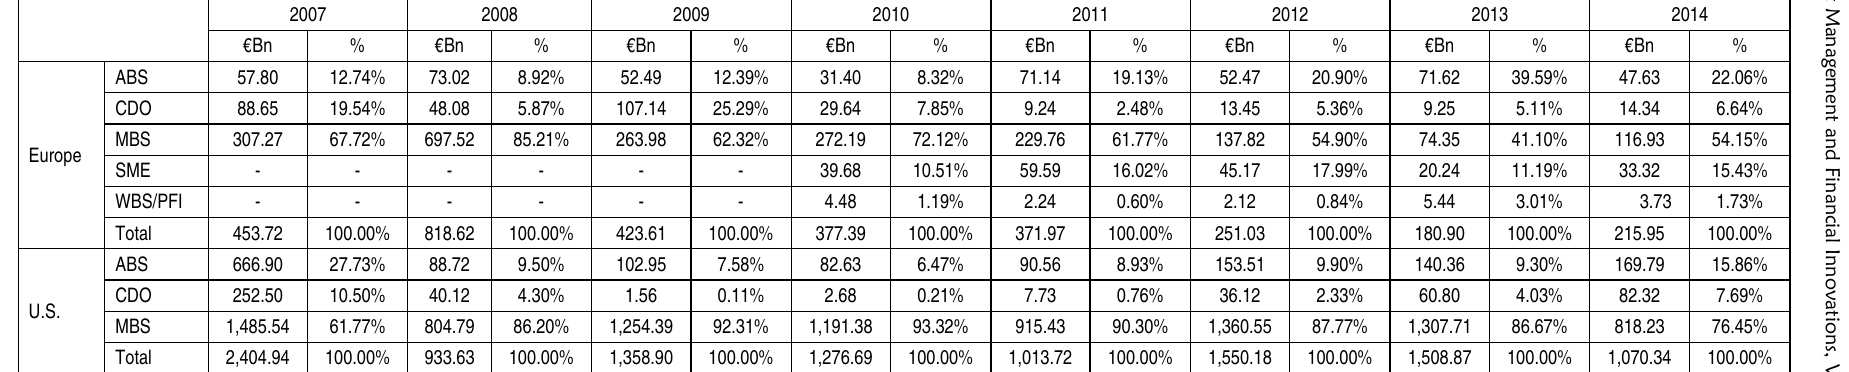
Table 6. Distribution of asset securitization bonds by collateral: Europe versus US